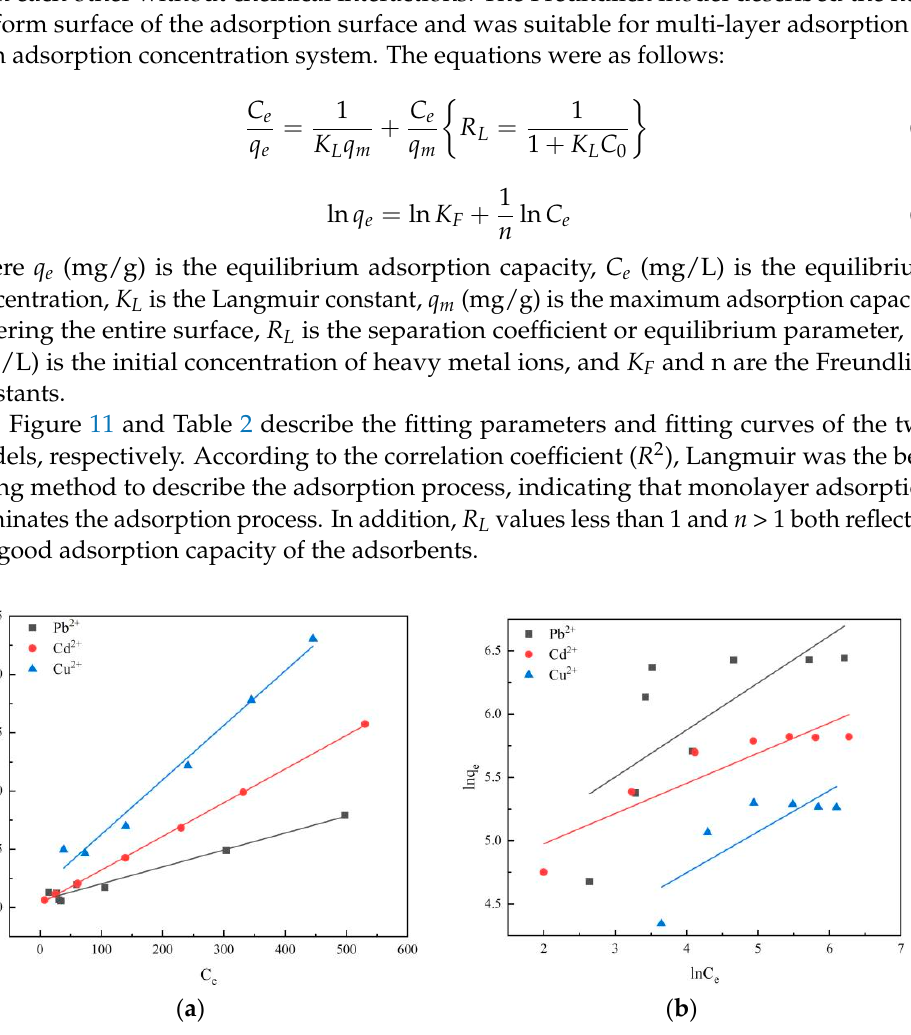
Figure 11. Langmuir ( a ), Freundlich ( b ) isotherm models of heavy metal ions adsorption on RIR/AA- Figure 11. Langmuir( a ),Freundlich( b )isothermmodelsofheavymetalionsadsorptiononRIR/AA-co-AM. co-AM. Table 2. Adsorption isotherms of heavy metal ions on RIR/AA-co-AM hydrogel. Table 2. Adsorption isotherms of heavy metal ions on RIR/AA-co-AM hydrogel. Langmuir Langmuir